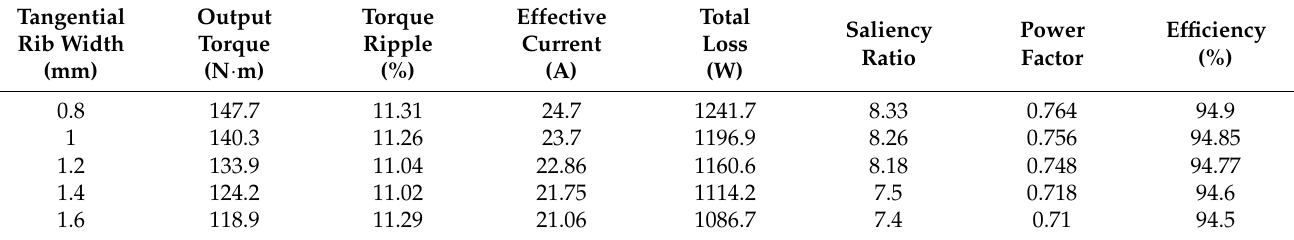
Table 8. Analysis on tangential rib widths.